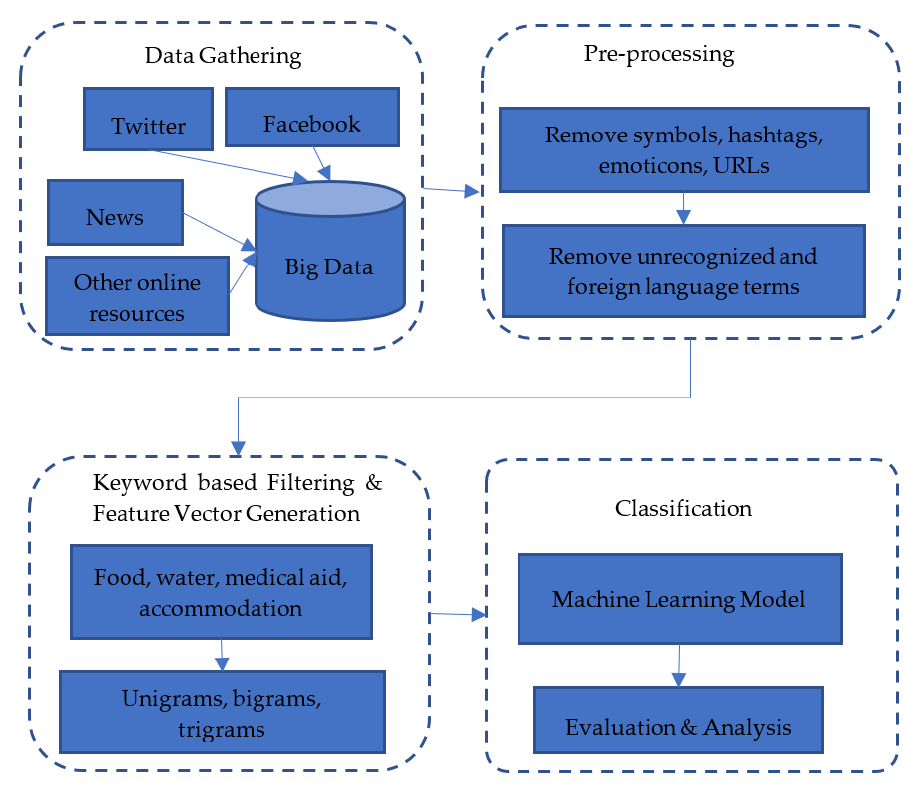
Figure 13. Proposed framework for utilizing social media big data for emergency and disaster relief.